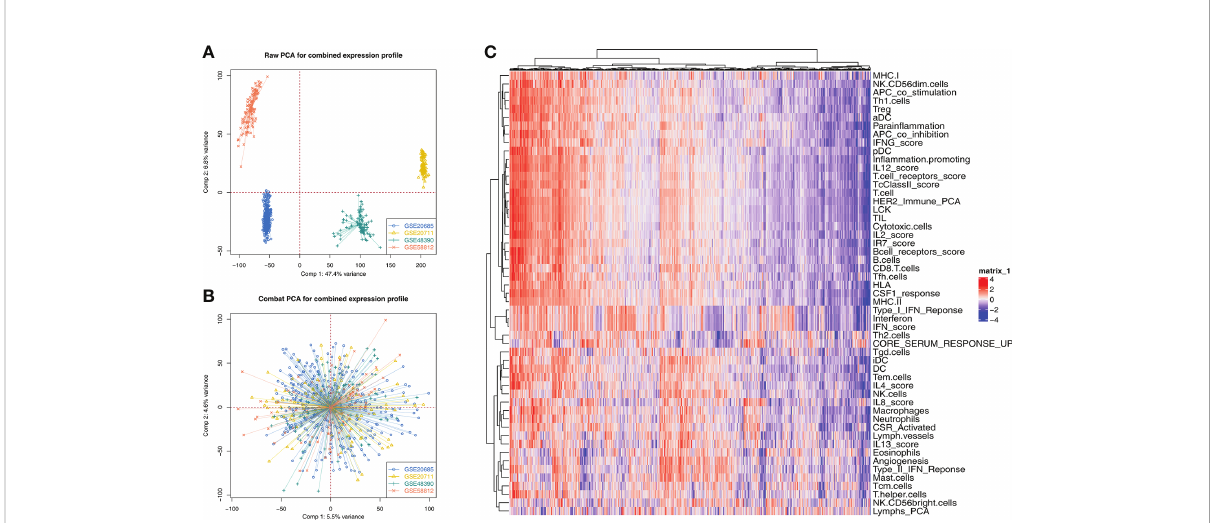
FIGURE 1 Data combination and immune terms quanti fi cation (A) Four GSE cohorts selected for our analysis have a signi fi cant batch difference, including GSE20685, GSE20711, GSE48390, and GSE58812; (B) The sva package used for cohort combination greatly reduces the batch difference. (C) ssGSEA algorithm was used to quantify 53 immune